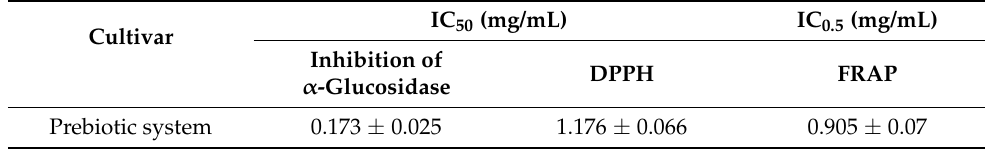
Table 4. In vitro activity of the lyophilized Cornus mas fruit system.